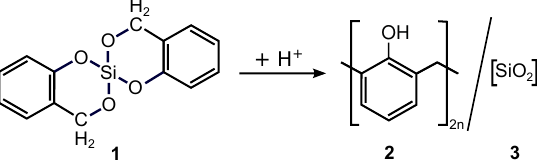
Figure 3. The acid catalyzed reaction scheme of the typical twin monomer 2,2 (cid:48) -spiro[4 H -1,3,2-benzodioxasiline] ( 1 ) is shown. 1 twin polymerizes to a phenolic resin ( 2 ) and a silica network ( 3 ).